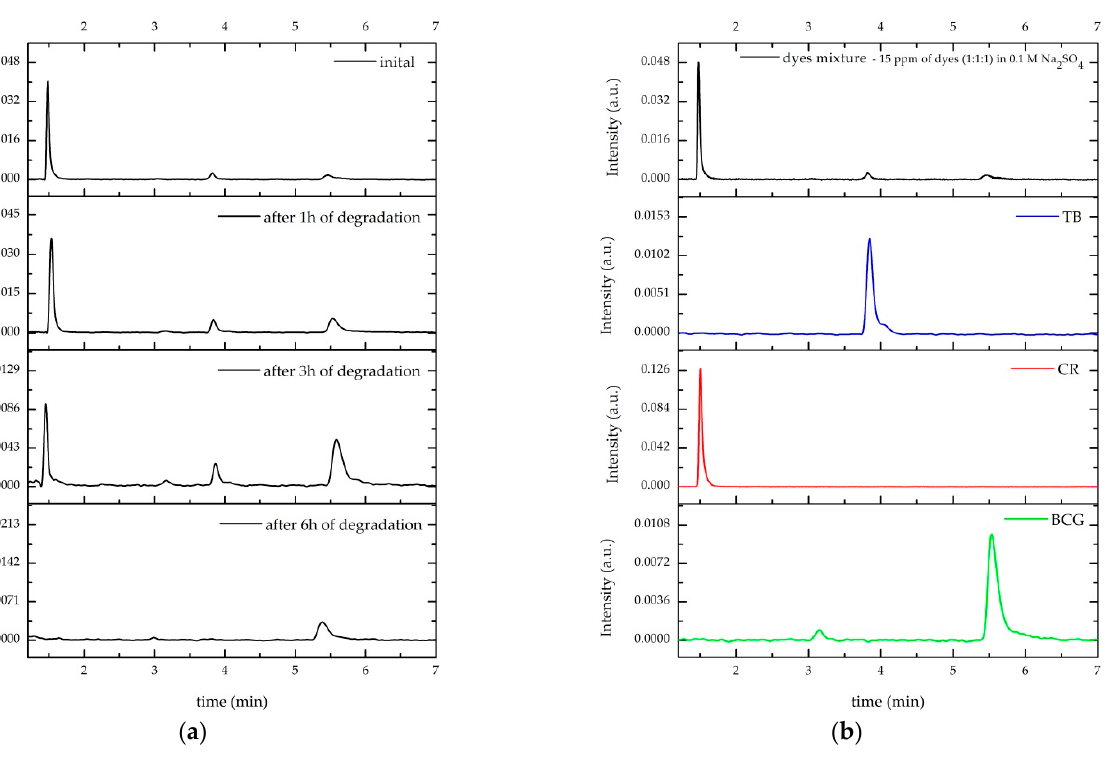
Figure 6. UPLC analysis: ( a ) Chromatograms of initial dyes mixture and solutions obtained during the degradation at GNP electrode at current density 10 mA/cm 2 ; ( b ) Individual chromatograms of dyes mixture and its components (BCG, CR, and TB).